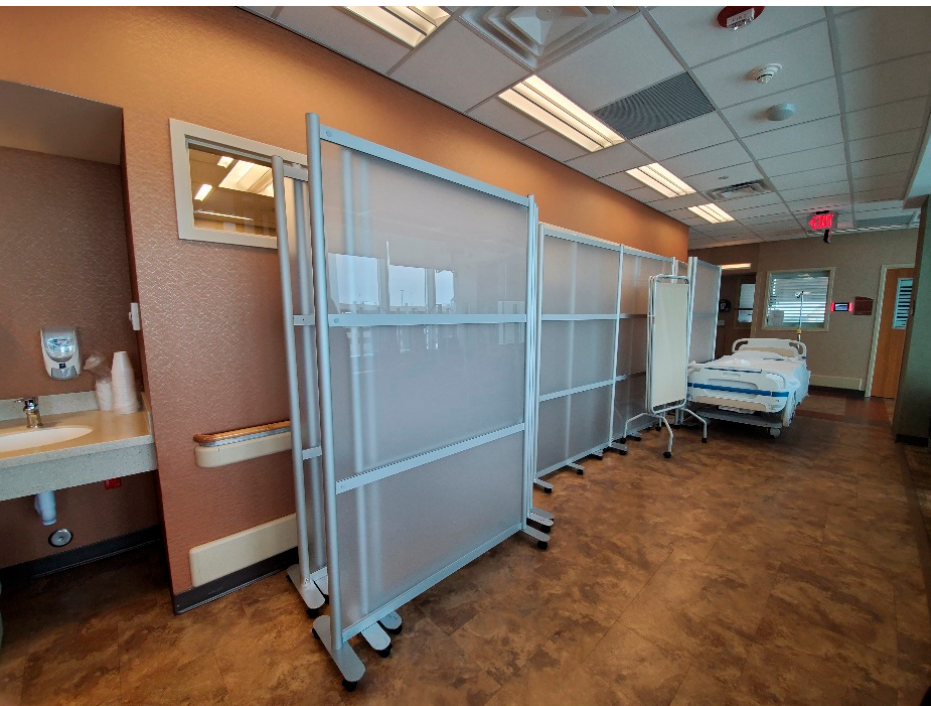
Figure 3. A divider placed between the patients in the double occupancy